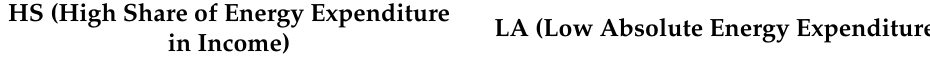
Table 1. Indicator generation: calculation